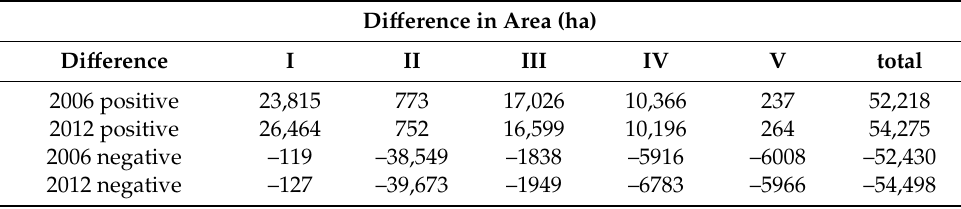
Table 9. The positive and negative di ff erences in the classes (in